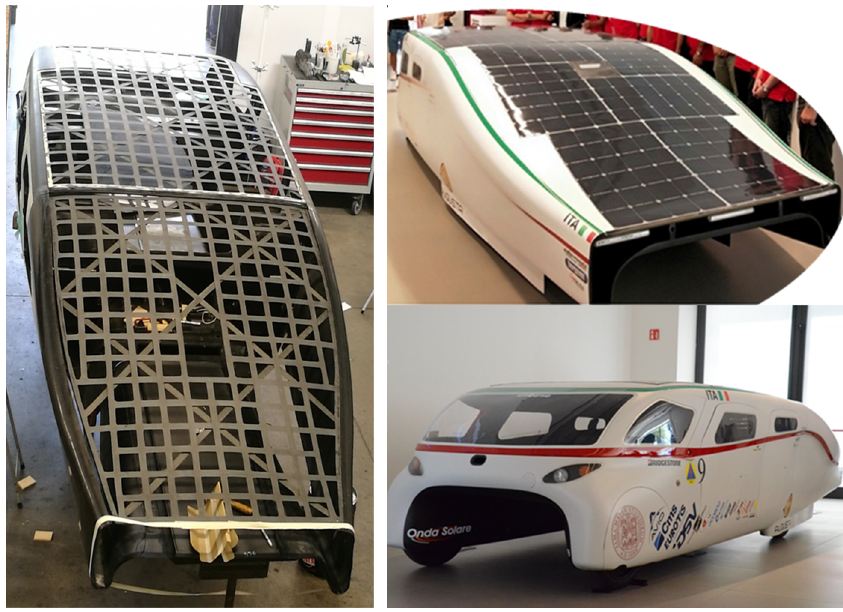
Figure 8. Solar roof manufacturing and installation on the solar vehicle.